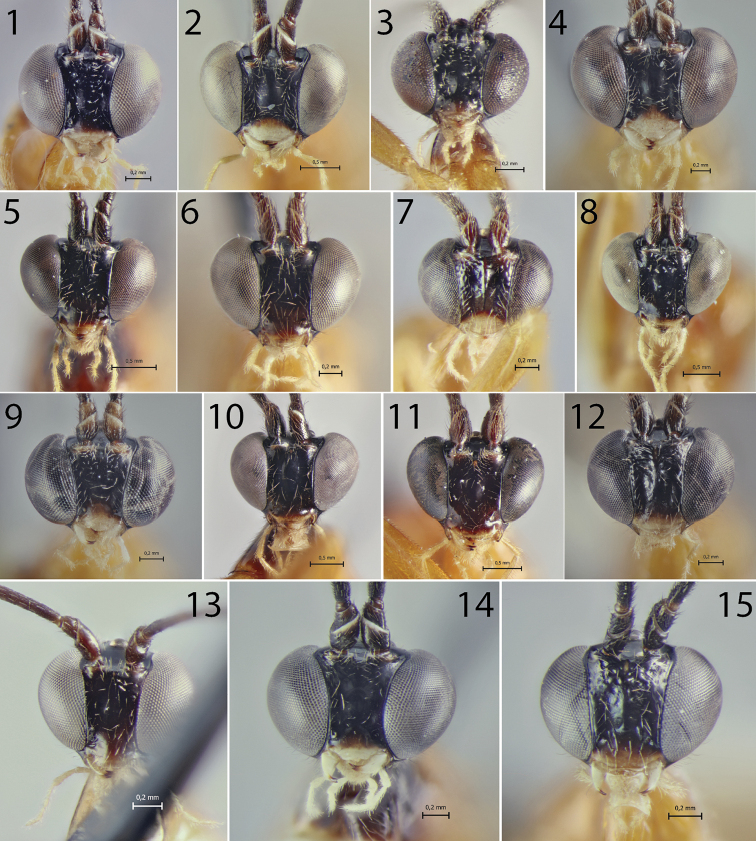
Heads of Hymenoepimecis spp. (females), frontal view 1H.
andina sp. nov. (holotype) 2H.
bicolor3H.
castilloi sp. nov. (holotype) 4H.
dolichocarinata sp. nov. (holotype) 5H.
duckensis6H.
ecuatoriana sp. nov. (holotype) 7H.
kleini8H.
longilobus sp. nov. (holotype) 9H.
manauara10H.
neotropica11H.
pucallpina sp. nov. (holotype) 12H.
rafaelmartinezi sp. nov. (holotype) 13H.
ribeiroi14H.
tedfordi15H.
uberensis.